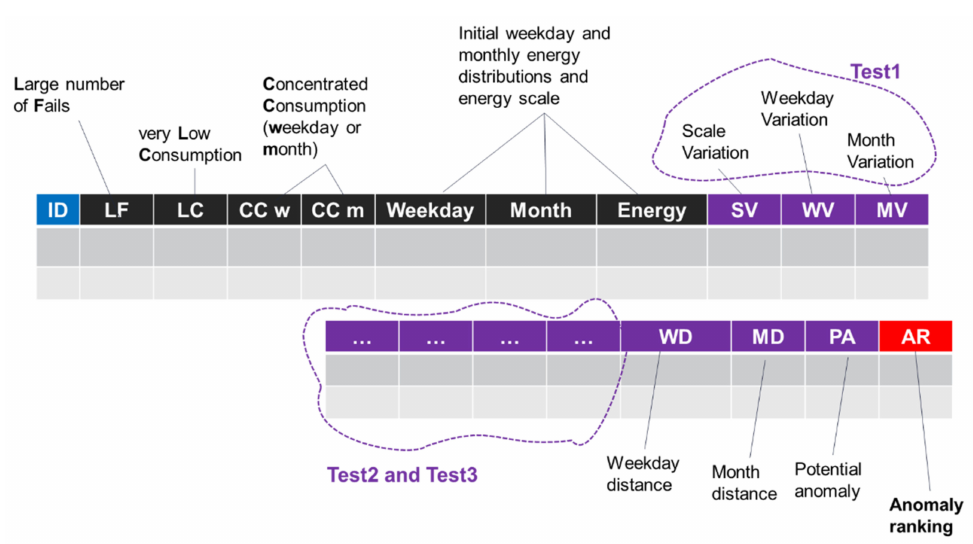
Figure 18. Building anomaly potential and ranking.